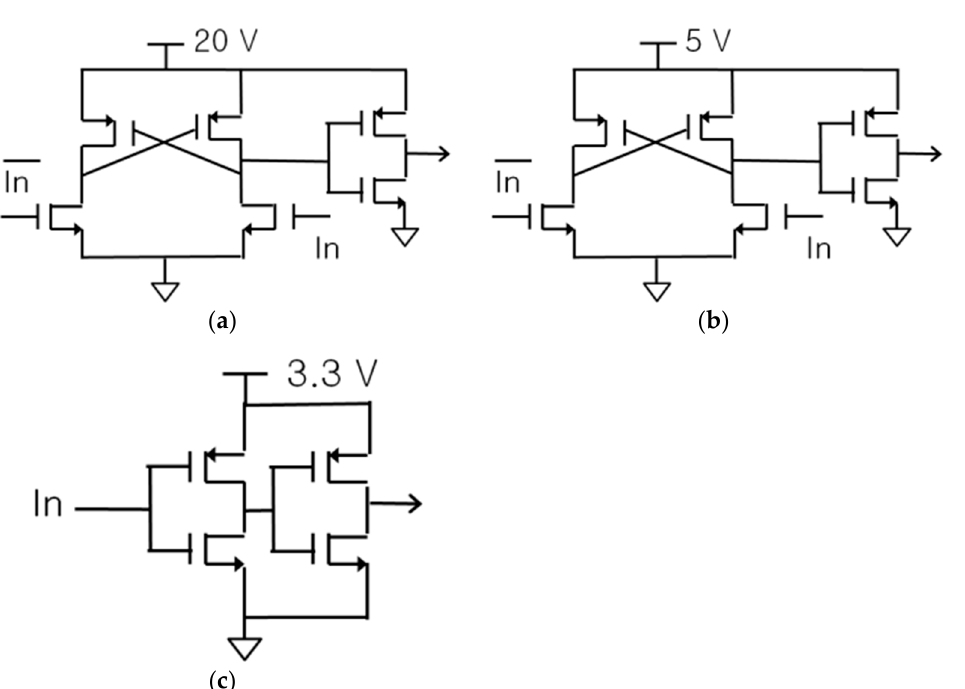
Figure 2. Schematic of low-side gate driver: ( a ) thick gate oxide, ( b ) mid-thickness gate oxide, ( c ) thin gate oxide.